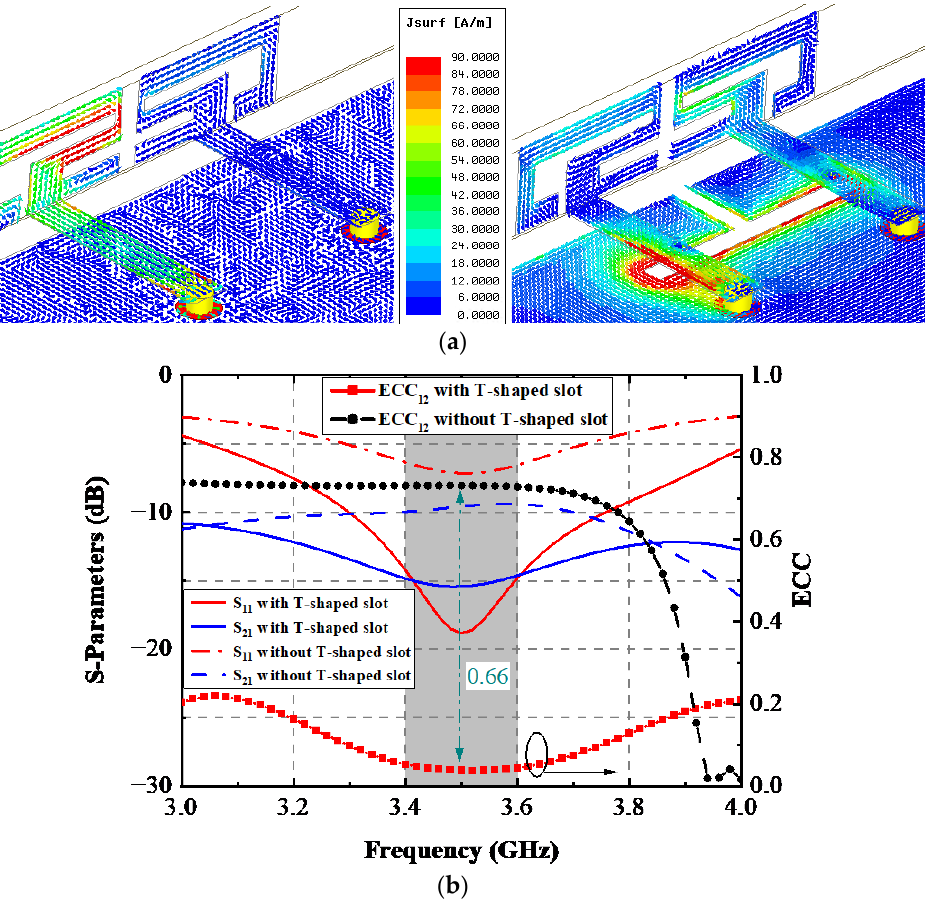
Figure 4. Simulated ( a ) surface current field and ( b ) results with the proposed AP without/with the T-shaped slot.